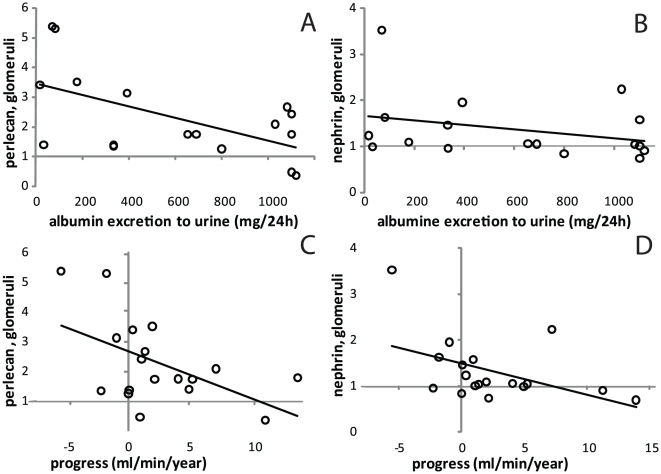
The relative gene expression of perlecan in the glomeruli from patients with IgAN at time of the biopsy correlates inversely to the patient's albumin excretion in urine, n = 17, r = −0.58, p<0.05 (A) and disease progression, n = 18, r = −0.52, p<0.05 (C).A high expression of perlecan at the time of the biopsy correlates to a lower albumin excretion and slower progression of the disease, implicating that the relative gene expression of perlecan can be used as a prognostic molecular marker in IgAN. The relative gene expression of nephrin did not correlate to urinary albumin excretion, n = 17 (B), but correlated inversely to disease progression, n = 18, r = −0.47, P<0.05 (D). This suggests that even the smallest changes in gene expression of nephrin may be important for disease progression in IgAN.